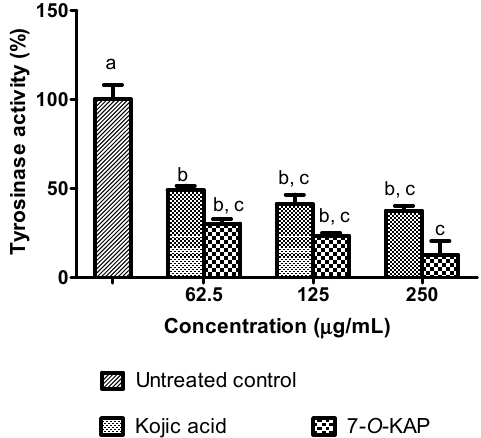
Figure 8. Melanin content of Danio rerio embryo after 48 h treatment with kojic acid and 7- O -kojic acid monopalmitate (7- O -KAP). The results are expressed as means ± S.E.M of percentage (%) to untreated control, n = 3. Kojic acid was used as a positive control. The letters a, b, and c indicate significant difference at p < 0.05 with Bonferroni’s Multiple Comparison Test.